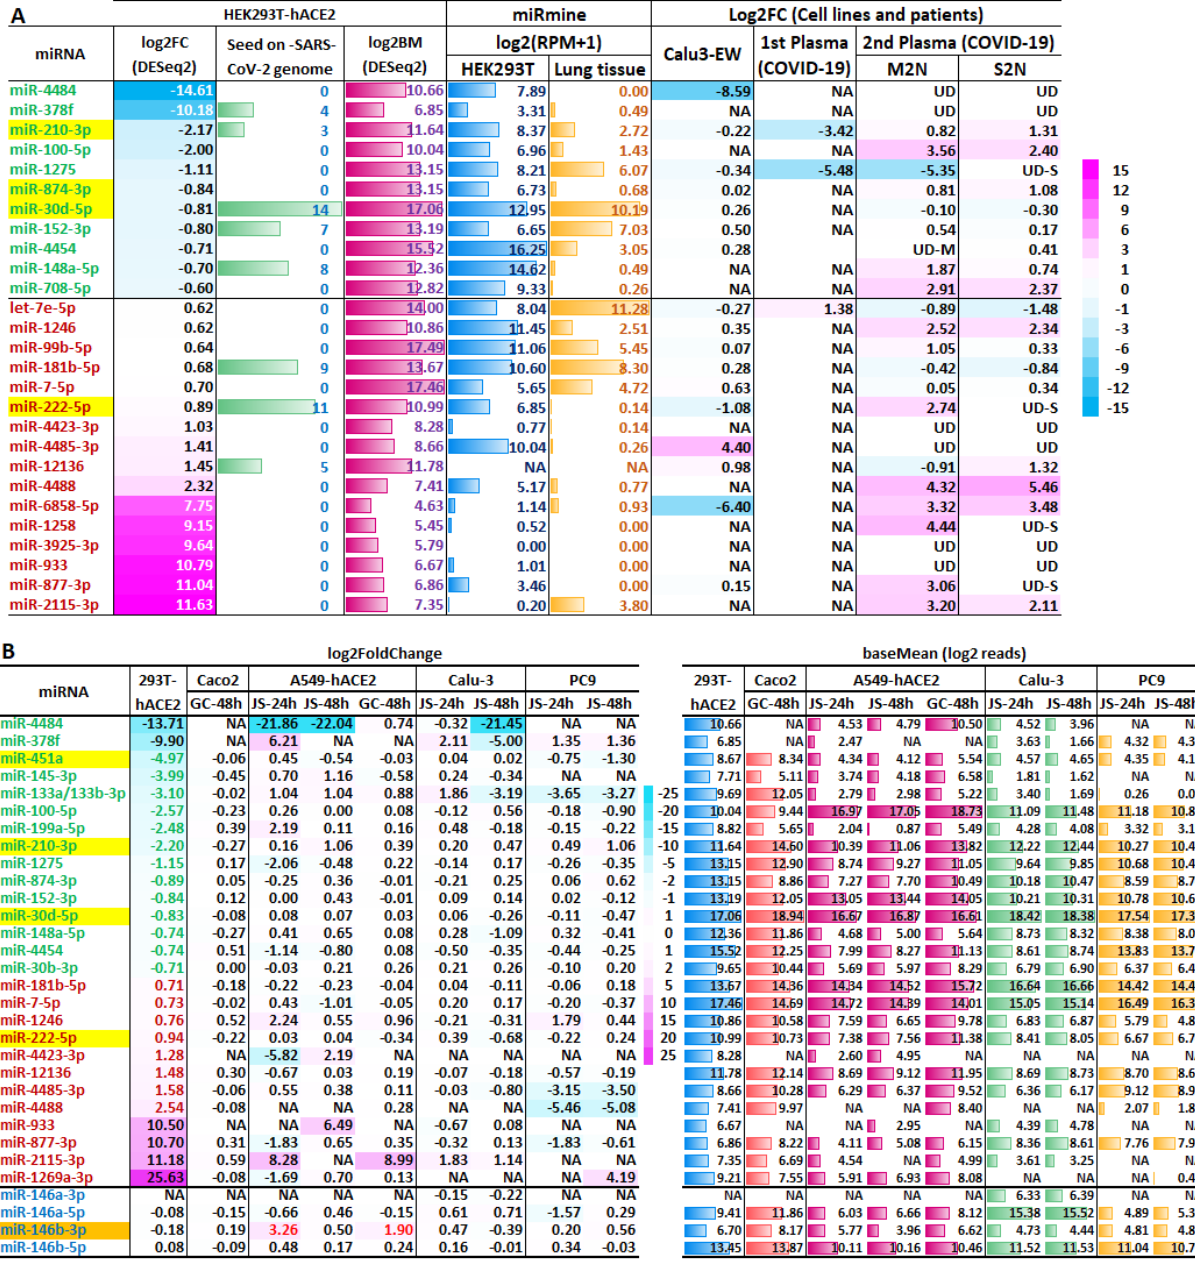
Figure 2. Significantly dysregulated small host RNAs in SARS-CoV-2-infected HEK293T-hACE2 cells and their expression in published datasets. ( A ) Unfiltered HEK293-hACE2 dataset versus datasets of Calu3-EW and plasma datasets of COVID-19 patients. Column “Log2FC” represents DESeq2 calculated log2 fold change of host miRNAs in SARS-CoV-2 infected cells versus mock infected cells. Column “Seed on SARS-CoV-2 genome” represents the number of host miRNA seed regions (nt #2 to 8 from 5′ end) complementary sequences on SARS -CoV-2 genome. Column “logBM” represents the average miRNA abundance in SARS-CoV-2 and mock-infected HEK293T-hACE2 cells measured by basic mean reads calculated with DESeq2. Column “log2(RPM + 1)” represents log2 values of miRmine analyzed RPM values plus one miRNA host in HEK293T cells (average RPM of six smRNAseq runs) or the human lung tissue (average RPM of two smRNAseq runs, miRmine defines RPM as reads per million miRNA reads, not all mapped reads). Column log2FC represent log2 fold changes of the significantly dysregulated miRNAs from HEK293T-hACE2 cells in SARS-CoV-2-infected Calu3-EW cells (Calu3-EW), the first plasma dataset of